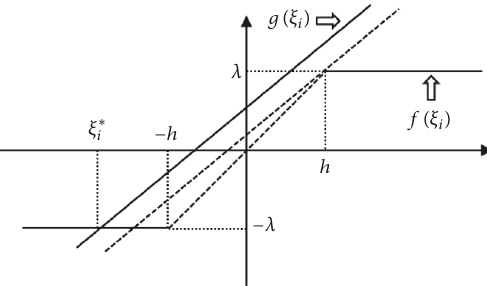
) = 𝑓(𝜉 ∗ ) , 𝜉 ∗ ≤ −ℎ,𝜉 ∗ 𝑖 𝑖 𝑖 is a 𝑖